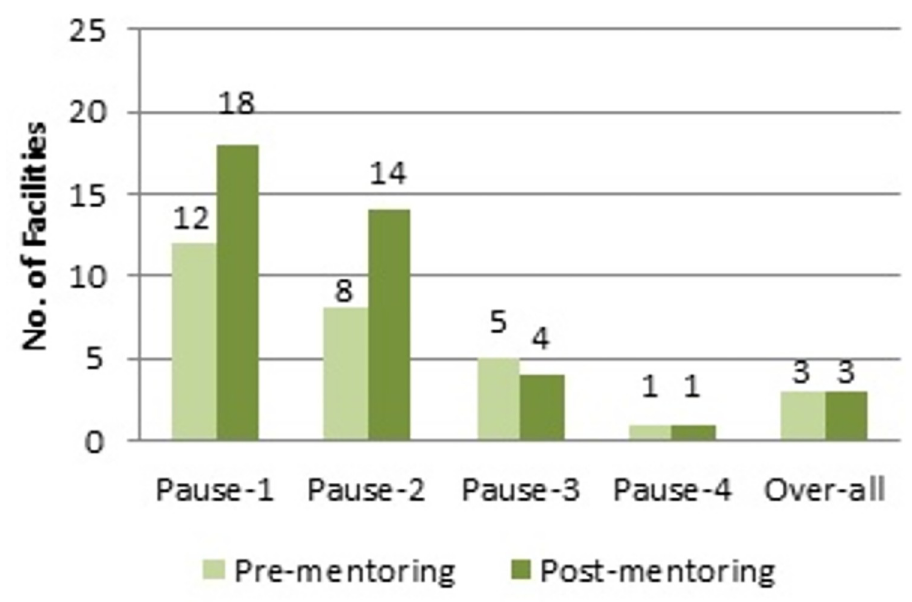
Fig 2. Number of facilities with score 4 or more in pause points and overall 14 or more, over time, N = 22.